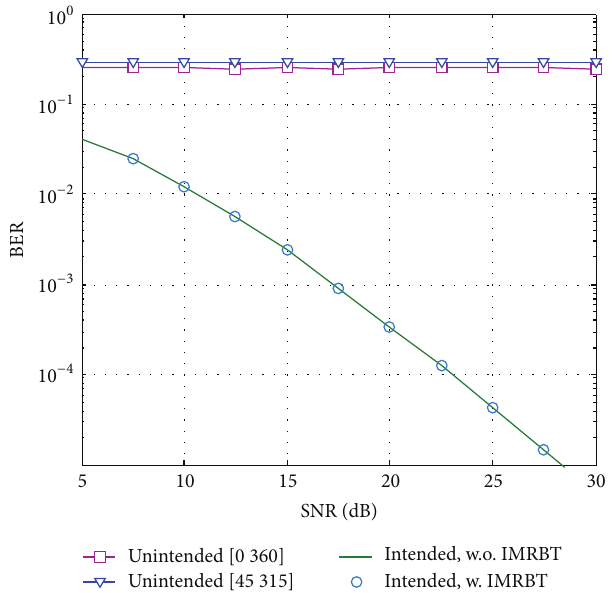
Figure 7: BER of the intended and unintended symbols with transmitters employing the proposed IMRBT scheme for 𝑛 𝐸 = 2 and QPSK